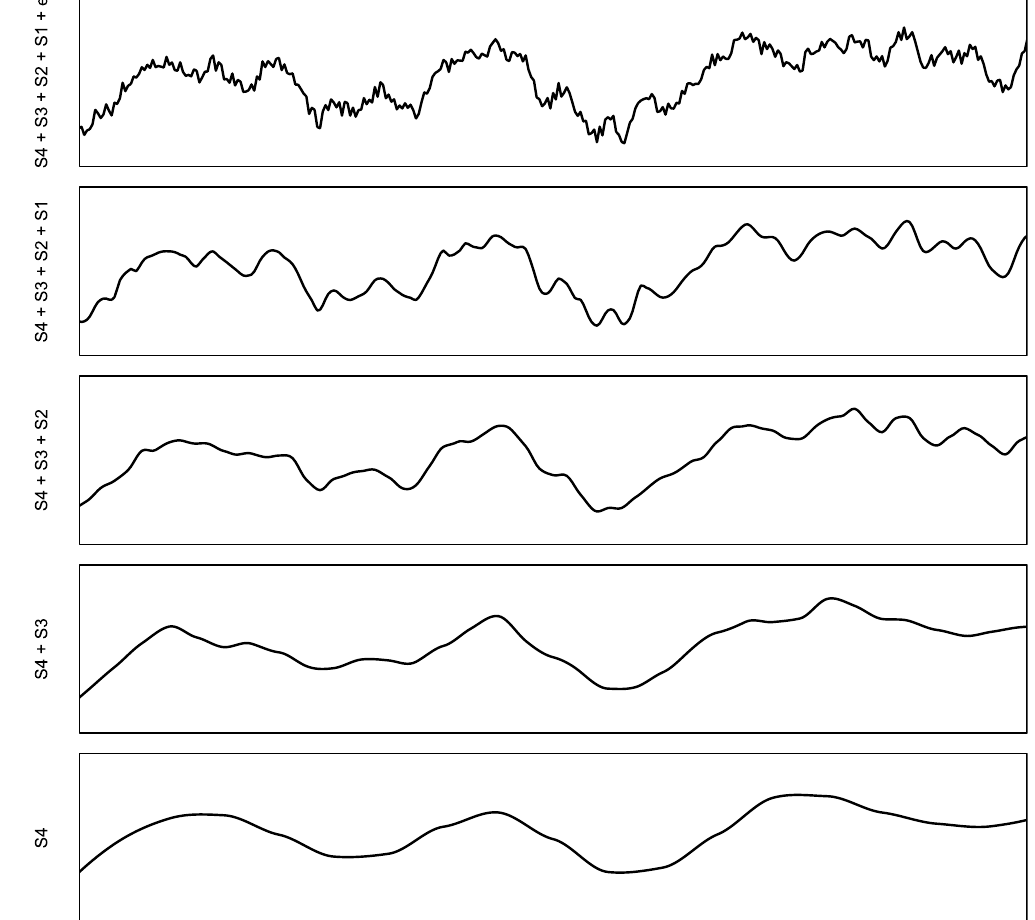
Figure 8. Decomposition of a signal of spatial variation into four components plus noise. Based on McBratney 42 . See also Fig. 13 in Hengl et al. 21